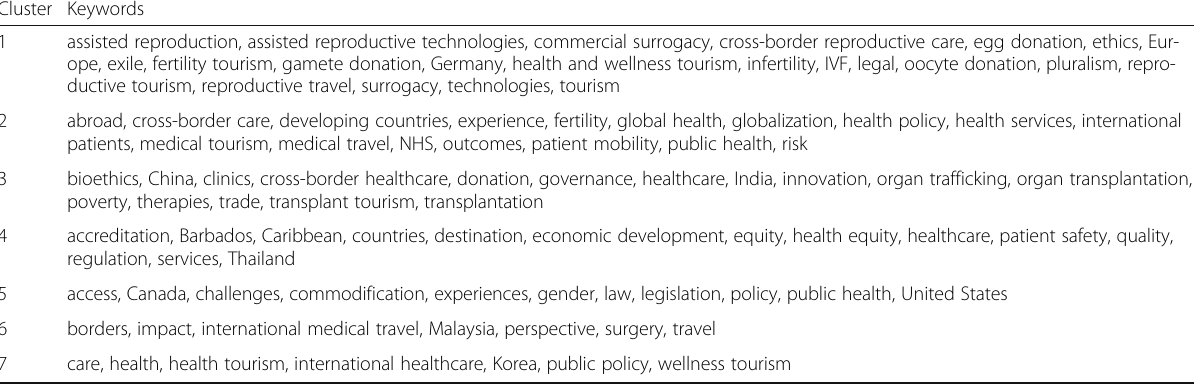
Table 5 Clusters of co-occurring keywords in policy-related publications on medical